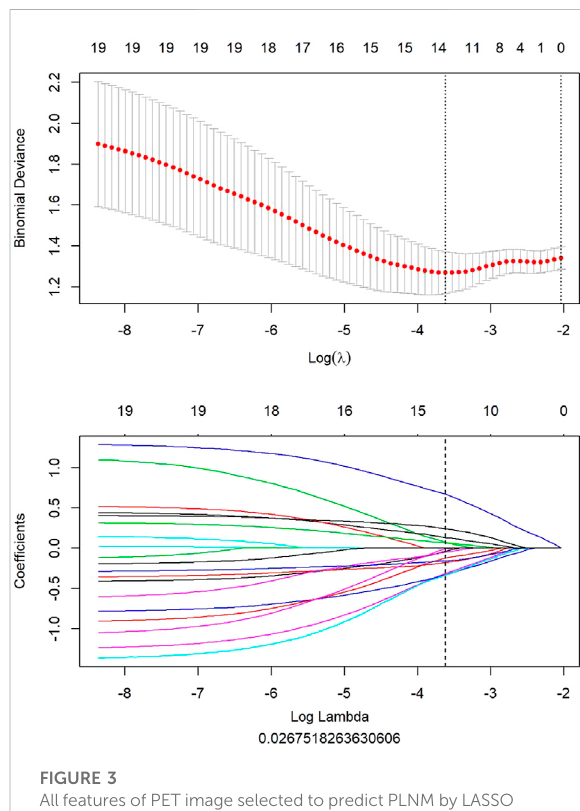
FIGURE 3 All features of PET image selected to predict PLNM by LASSO algorithm. When lambda was 0.027 in predicting PLNM with the LASSO algorithm, 14 most informative features were reserved to predict PLNM in the training